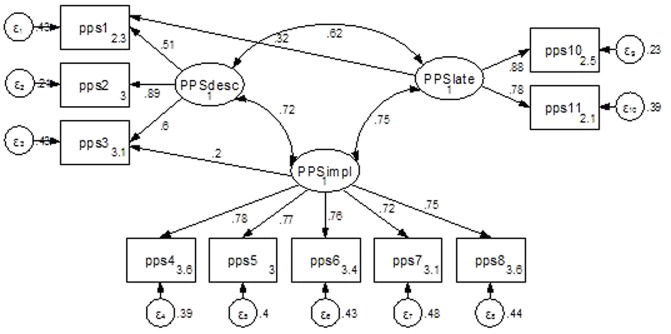
Final three-factor model for the Pure Procrastination Scale (PPS). PPSdesc = items 1–3, PPSimpl = items 4–8, PPSlate = items 9–12. Standardized estimates shown.